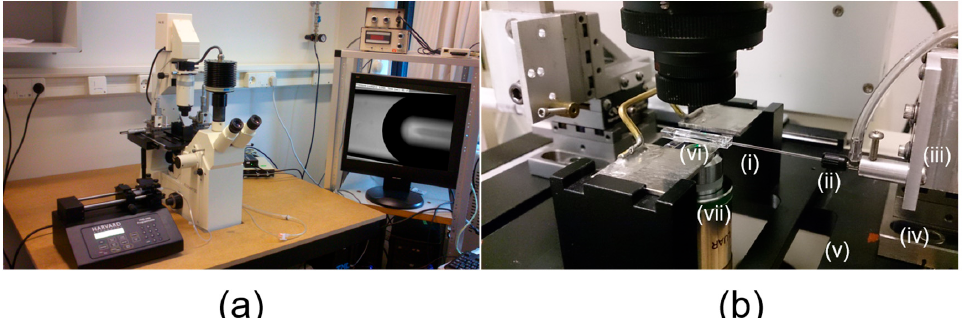
Figure 4. Our Signature Micropipette Manipulation Platform provides an ability to establish a well-defined interface (air-water, oil-water, with or without adsorbed material). ( a ) The system is comprised of: micropipette pressure control from micro-atm to milli-atm; a microchamber for the test solution; temperature control: 5 to 50 ◦ C; manipulators with fine positional control of pipette. Microscope images are recorded digitally for analysis. ( b ) Micropipette (i) is mounted via a chuck (ii) in a custom-built holder (iii), mounted on a stage micrometre (iv) bolted firmly to the microscope platform (v). The image of the micropipette in the microchamber (vi) is viewed via a 40 × and 20 × objective lens for equilibrium and dynamic surface tension measurement, respectively (vii).